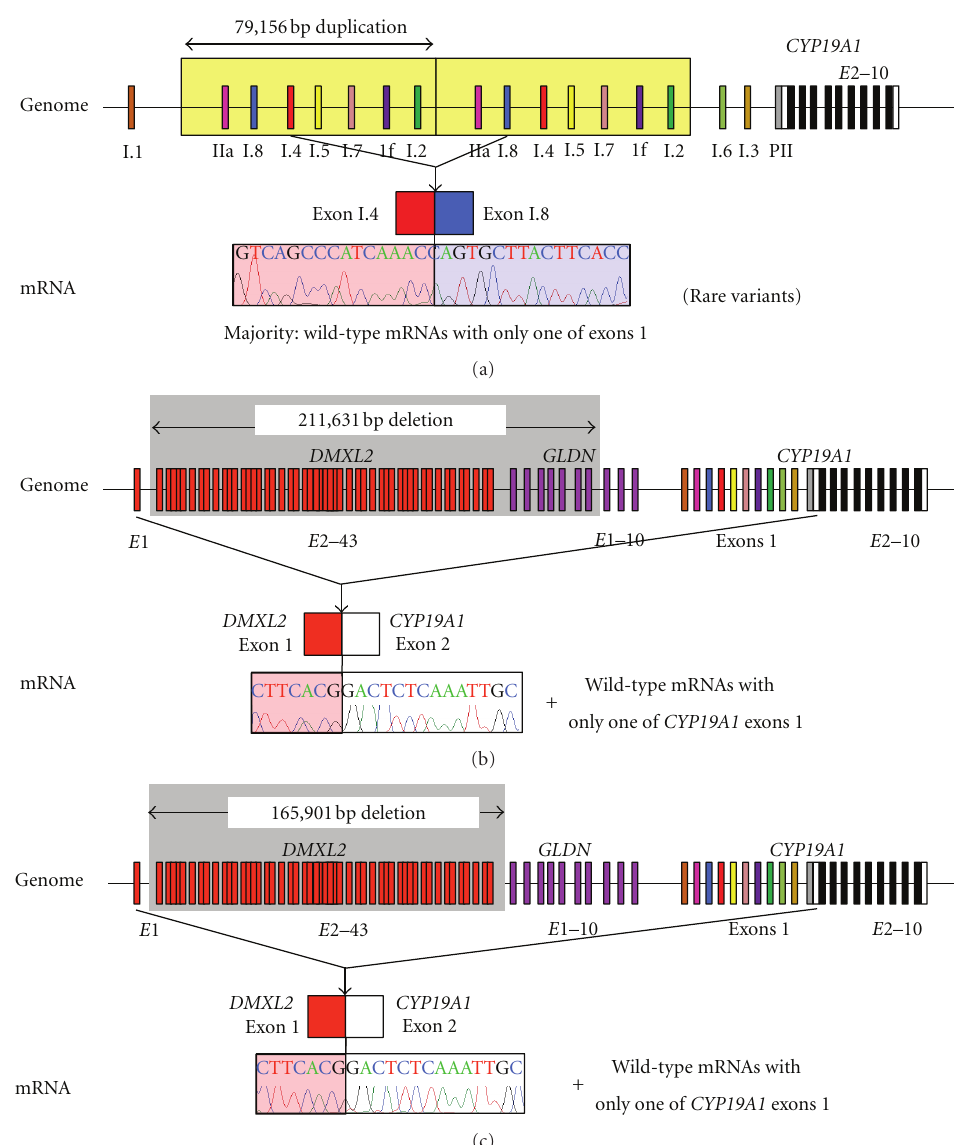
Figure 2: Schematic representation of duplications and deletions identified in patients with AEXS. (a) the tandem duplication of families A and B [4]. Genome: the duplication (yellow boxes) includes seven of the 11 noncoding exons 1 of CYP19A1 . mRNA: the sequence of a rare transcript is shown. The 3 (cid:3) -end of exon I.4 is connected with the 5 (cid:3) -end of exon I.8. (b) The deletion of family C [4]. Genome: the deletion (a gray area) includes exons 2–43 of DMXL2 and exons 5–10 of GLDN . mRNA: The sequence of a rare chimeric gene transcript is shown. DMXL2 exon 1 consisting of a noncoding region and a coding region is spliced onto the common acceptor site of CYP19A1 exon 2. (c) The deletion of families D–F [4]. Genome: the deletion (a gray area) includes exons 2–43 of DMXL2 . mRNA: the sequence of a rare chimeric gene transcript is delineated. The mRNA structure is the same as that detected in family